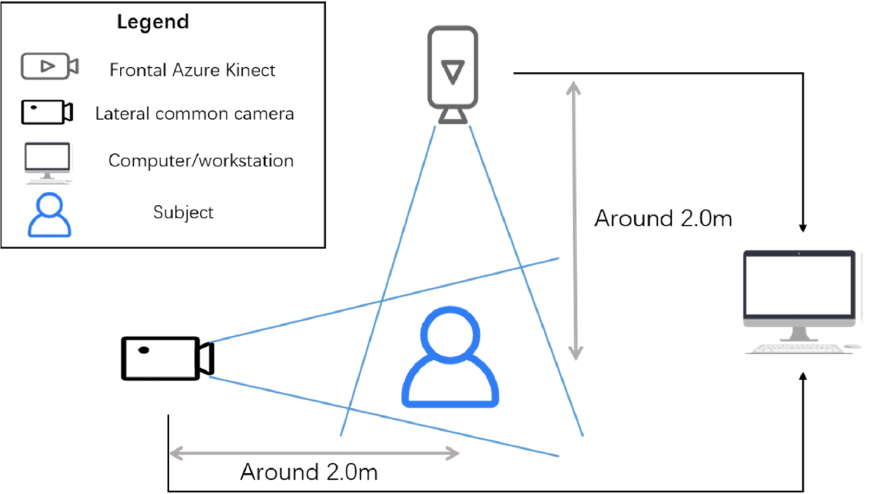
Figure 3. Devices Diagram for the multi-view vision based method.